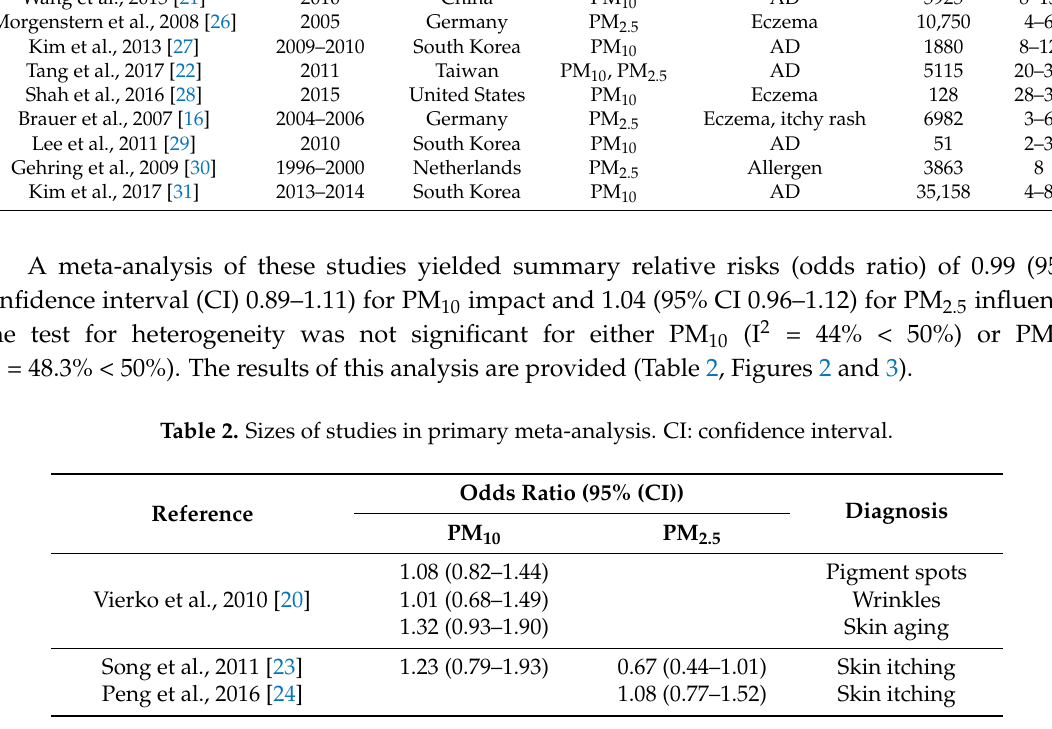
Table 2. Sizes of studies in primary meta-analysis. CI: confidence interval.